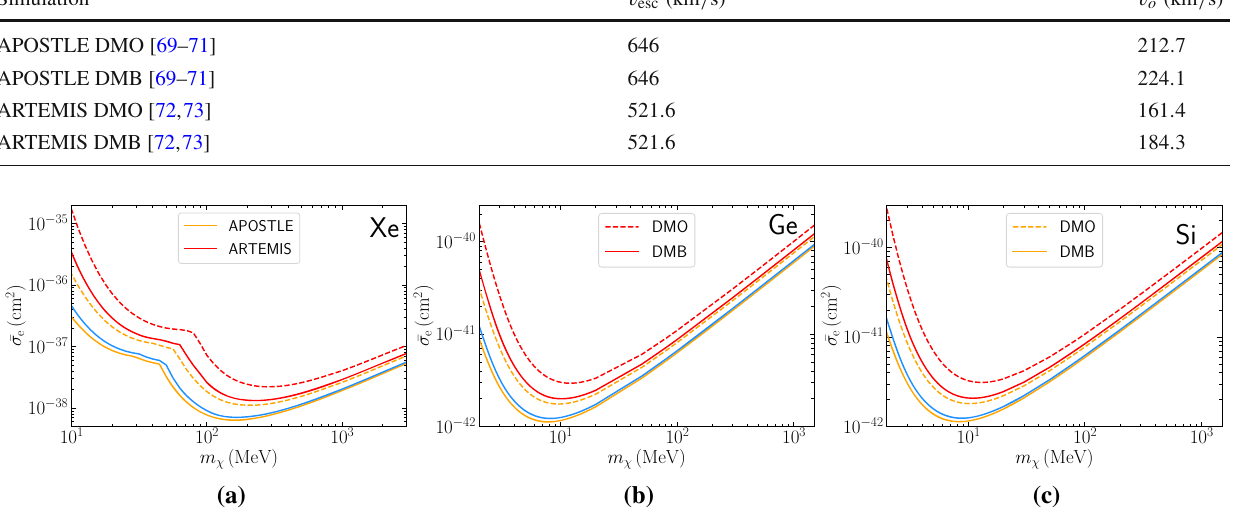
Table 1 Best fit parameters for the SHM. DMO refers to the DM only simulation. DMB indicates the simulation which takes into account both DM and baryon smooth particle hydrodynamics Simulation